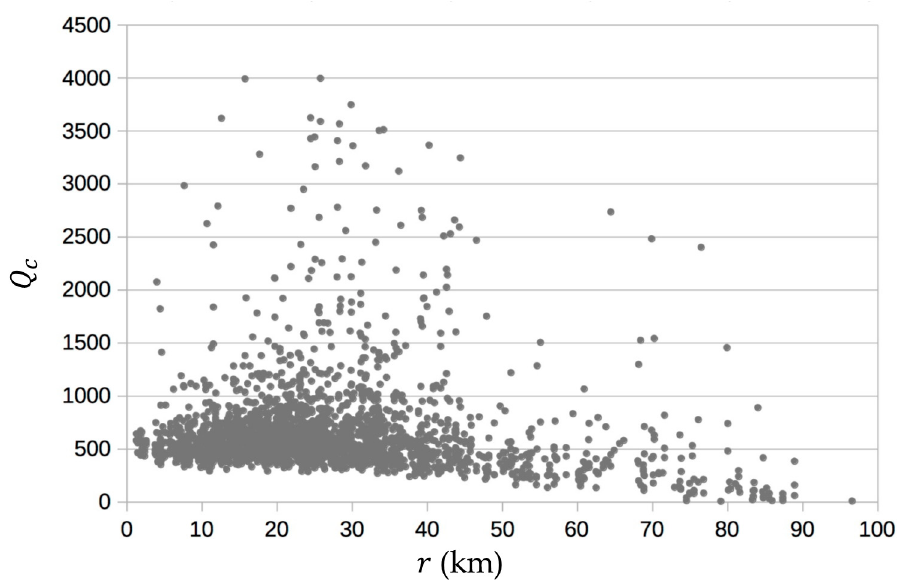
Figure 9. Q c trend versus the source-to-receiver distance r (km) for f c = 12 Hz and t L = 30 Figure 9. 𝑄 (cid:3030) trend versus the source-to-receiver distance 𝑟 (km) for 𝑓 (cid:3030) = 12 Hz and 𝑡 (cid:3013) = 30 s. In summary, from the 𝑄 (cid:3030) tomography at 𝑓 (cid:3030) = 12 Hz (Figure 8c), it can be observed C zone); in the lower crust, 𝑄 (cid:3030) increases toward the northeast (trend from the zone with